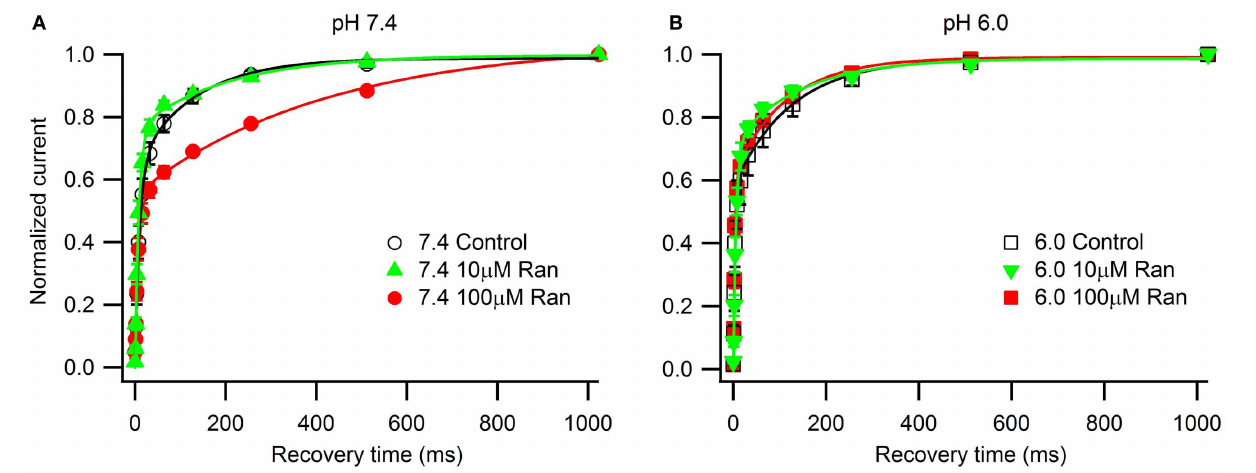
doubleexponentialfunction. (A) pH7.4 in control(openblack circles), 10 μ M ranolazine(solid greentriangles),and 100 μ M ranolazine (solid red circles). (B)